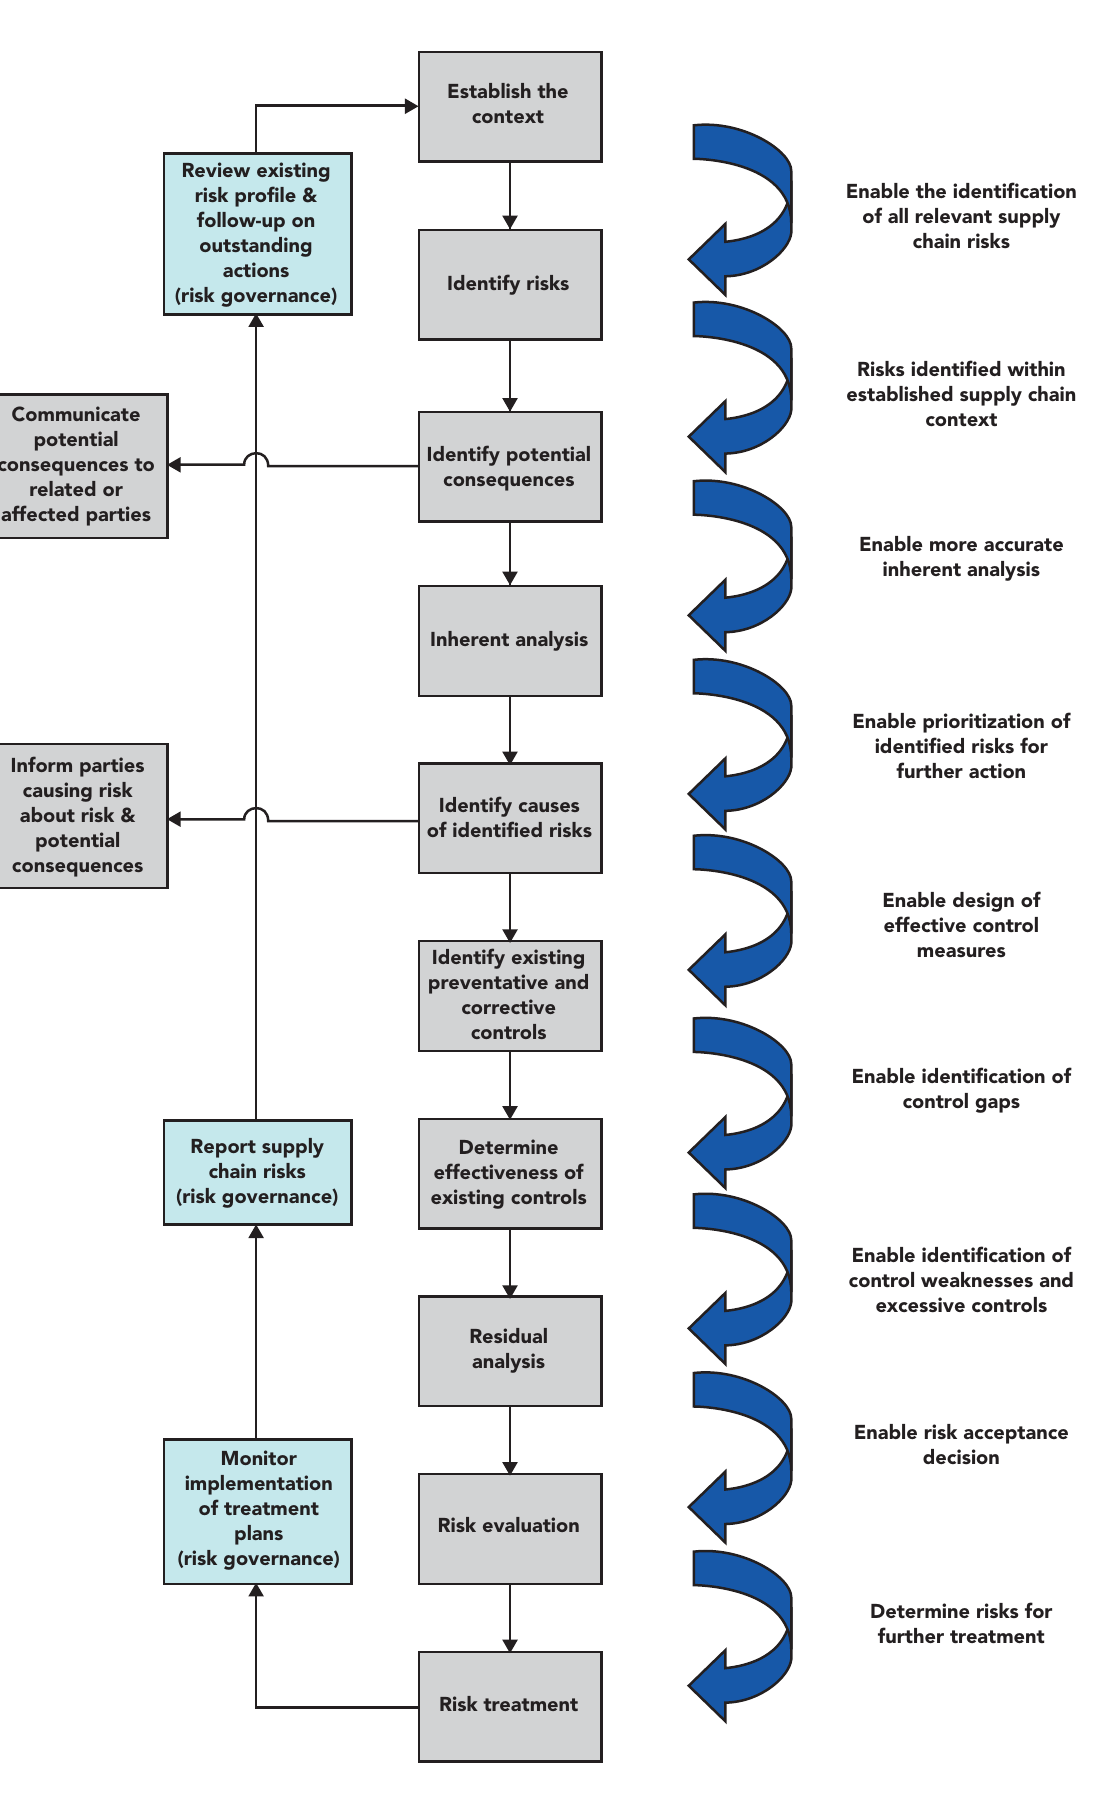
Figure 2: Integrated supply chain risk management process Source: Compiled by the authors for the purposes of the